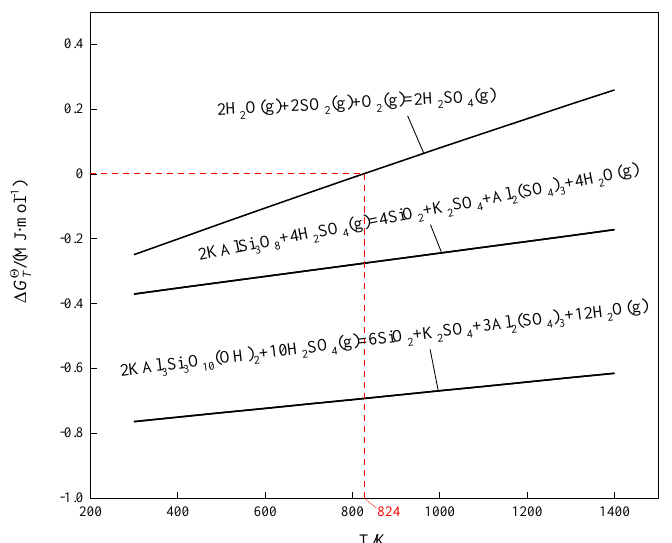
Figure 6. Thermodynamic analysis of soluble potassium from orthoclase.